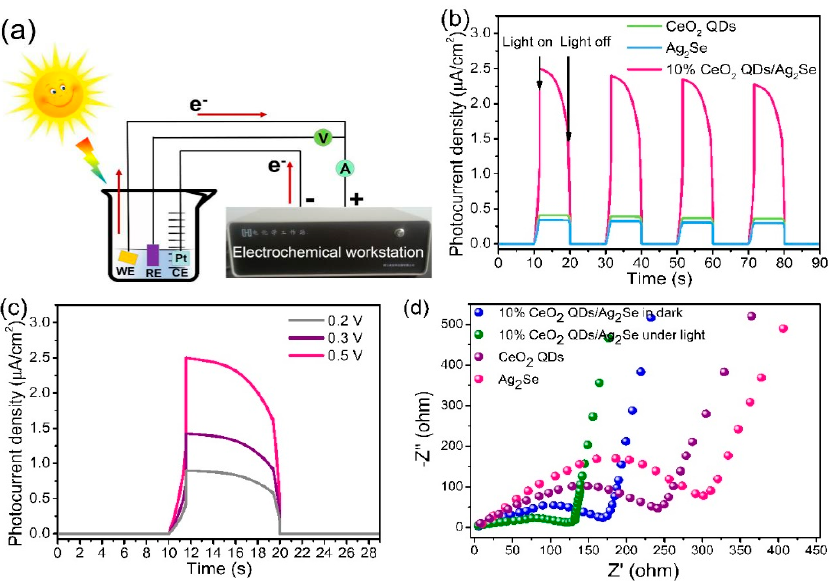
Figure 10. ( a ) Schematic diagram of the test setup, ( b ) transient photocurrent plots of CeO 2 QDs, Ag 2 Se, and 10% CeO 2 QDs/Ag 2 Se at 0.5 V vs. CE, ( c ) photocurrent plots of 10% CeO 2 QDs/Ag 2 Se at different biases, ( d ) EIS spectra of CeO 2 QDs , Ag 2 Se, and 10% CeO 2 QDs/Ag 2